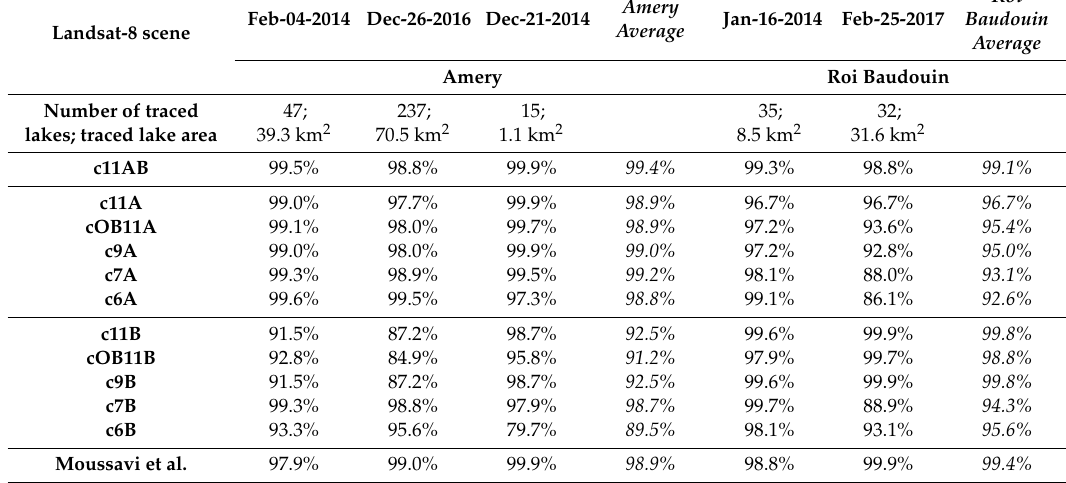
Table 2. High-confidence manual lake and non-lake polygons are produced for five Landsat scenes. The pixels contained by manually traced polygons are classified to calculate the lake / non-lake accuracy assessments shown here. Percentages are classifier lake / non-lake overall accuracy applied to the lake / non-lake polygon dataset. Validation scenes are identified by date (year-month-day); full names are listed in Table